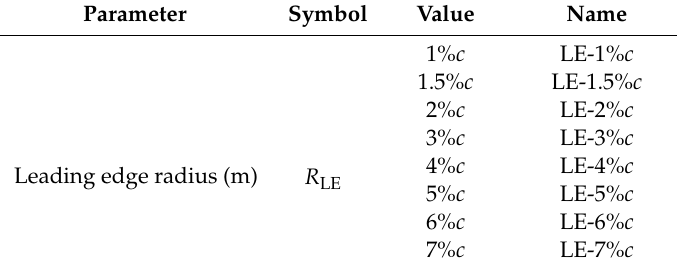
Table 1. Characteristics of modified airfoils.